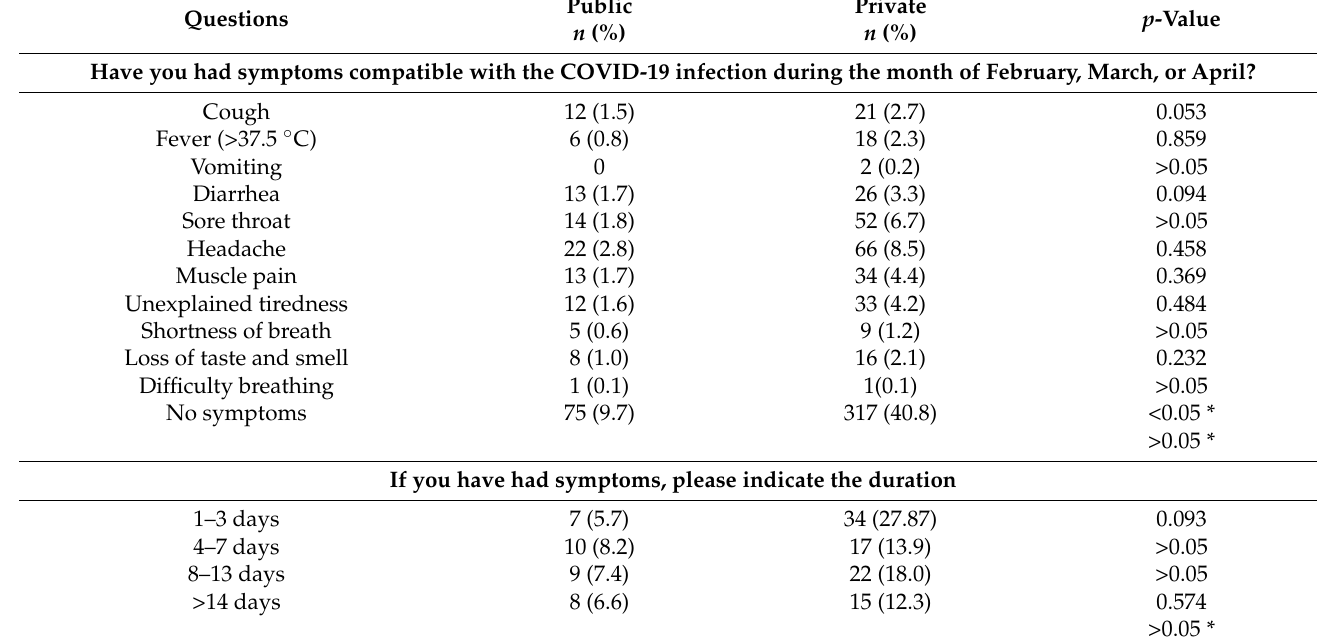
Table 4. Symptoms and professional isolation due to COVID-19 among dental